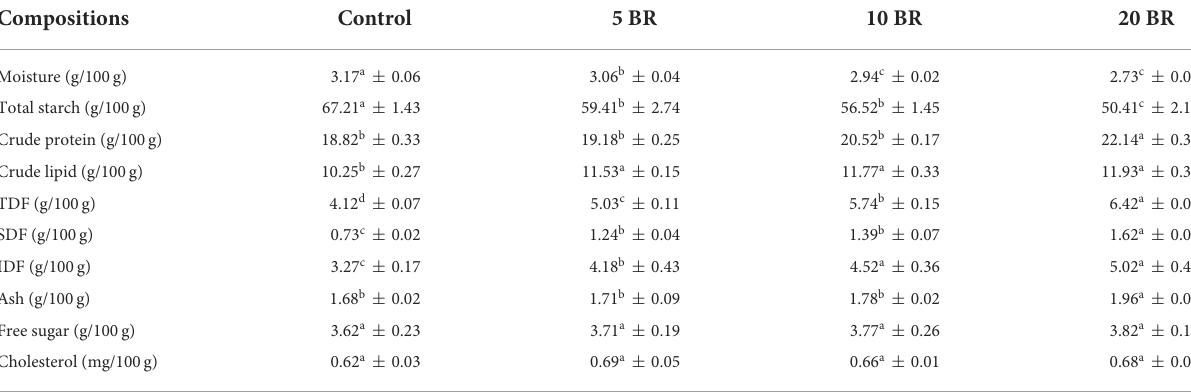
TABLE 3 Nutrition composition (on a dry weight basis) of flaky rolls incorporated with different proportions of black rice flour. Compositions